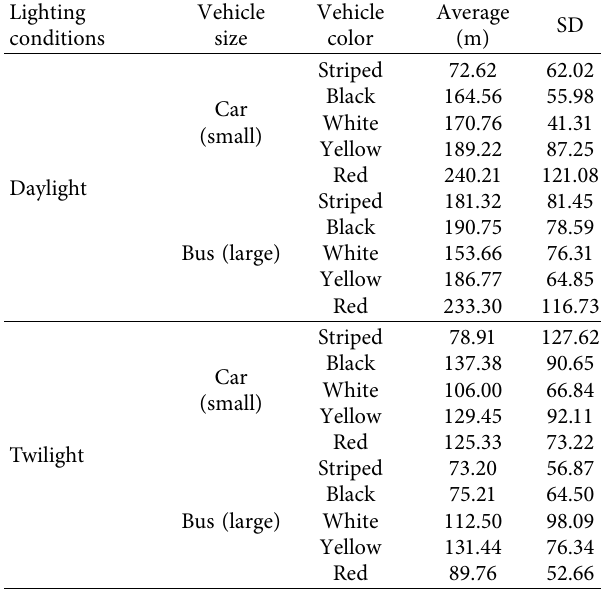
Table 6: Descriptive statistics for the rear identification